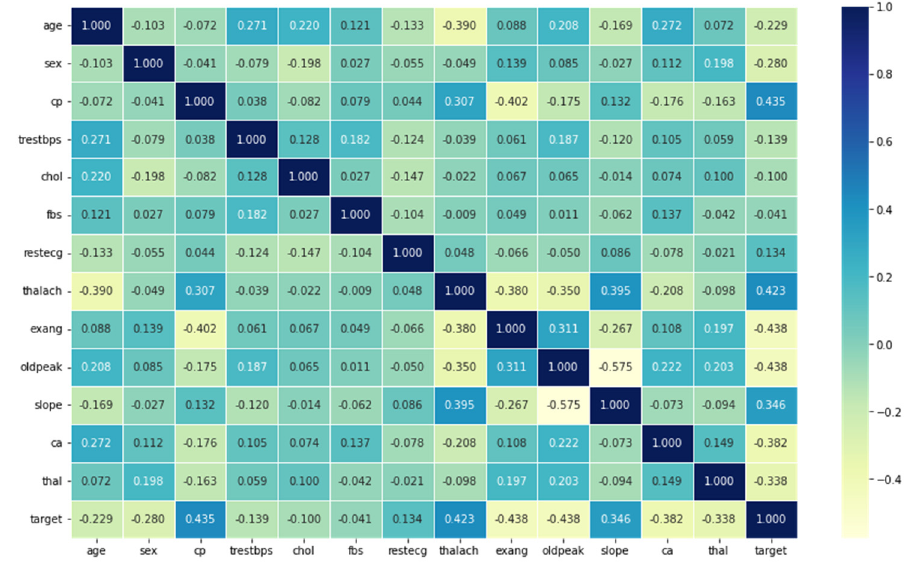
Figure 5. Feature Correlation Matrix for PIMA Dataset.